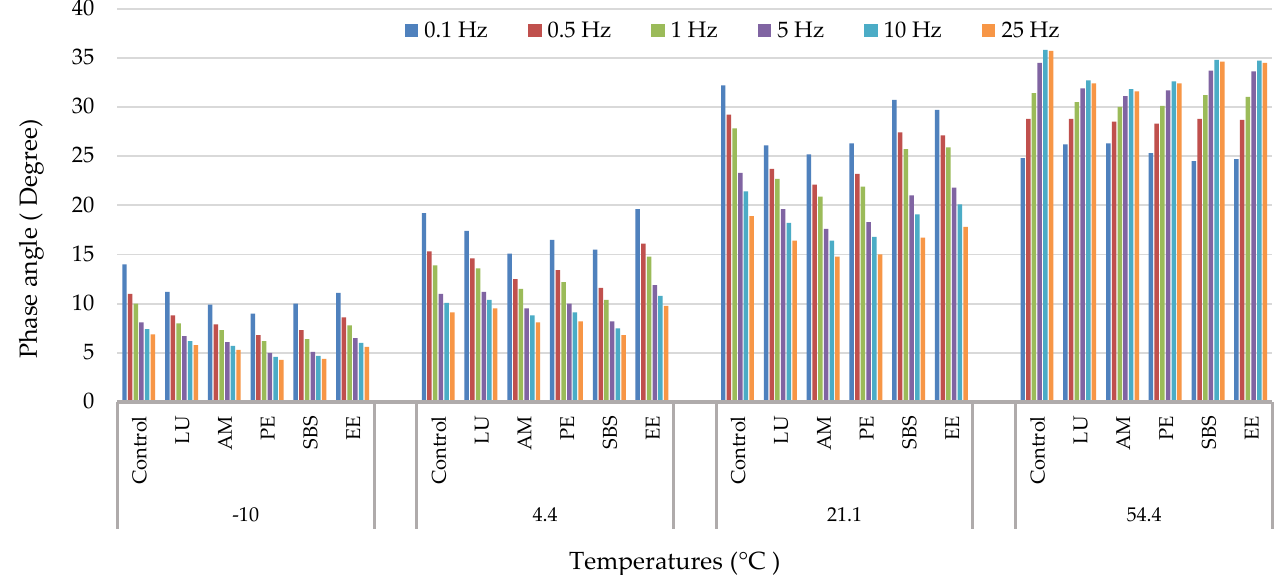
Figure 8. Dynamic modulus versus frequencies at different temperature.